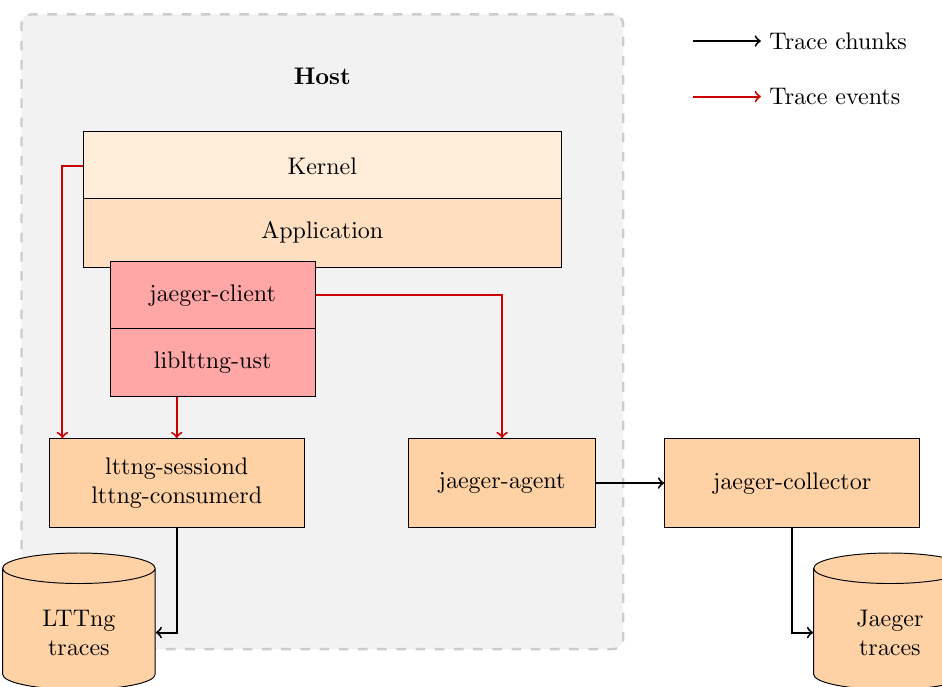
Figure 4. Design of our trace collection solution. Our solution targets a single host and is able to collect kernel traces using LTTng and distributed traces using Jaeger. The in-process Jaeger client is patched to emit LTTng user-space events and has to be compiled against liblttng-ust . The application code is unmodified, but it has to be compiled against the patched Jaeger client.